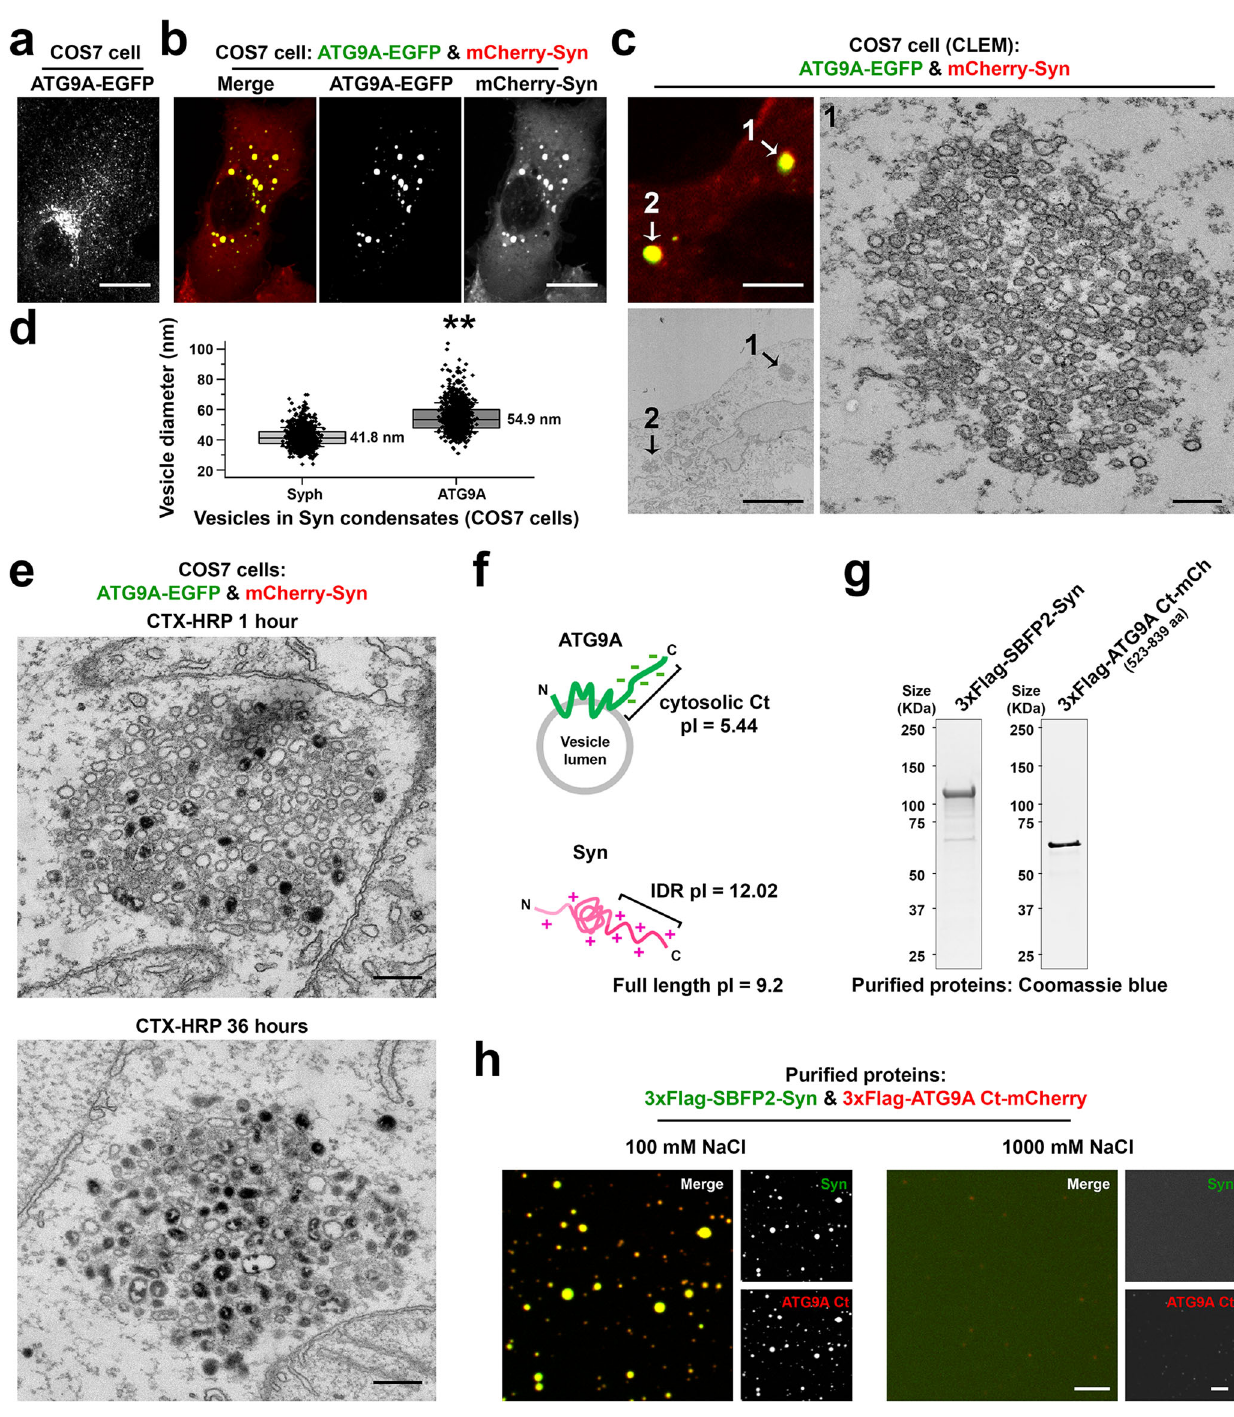
Fig.3|Co-expressionofATG9A-EGFPwithmCherry-synapsinresultsinclusters ofsmallvesicles.a , b ATG9A-EGFPwasexpressedeitheralone( a )orwithmCherry- synapsin 1a ( b ) in COS7 cells. c Correlative light-electron microscopy (CLEM) of a COS7 cell co-expressing ATG9A-EGFP and mCherry-synapsin. Left: arrowheads point to droplets positive for ATG9A-EGFP and mCherry-synapsin in the fl uores- cence and EM images. Right: high-magni fi cation EM image of droplet #1. d Size distribution of the ATG9A and synaptophysin vesicles when these two proteins are expressed independently with synapsin. Box plots show the median line (midline), 25/75 percentiles (boxes), and SD (whiskers). Data are represented as mean±SD. 1000 vesicles were measured for each group (from three independent experi- ments).** p <0.01,bytwo-sidedStudent ’ s t -test. e COS7cellsco-expressingATG9A- EGFP and mCherry-synapsin were treated with 10 μ g/ml cholera toxin conjugated